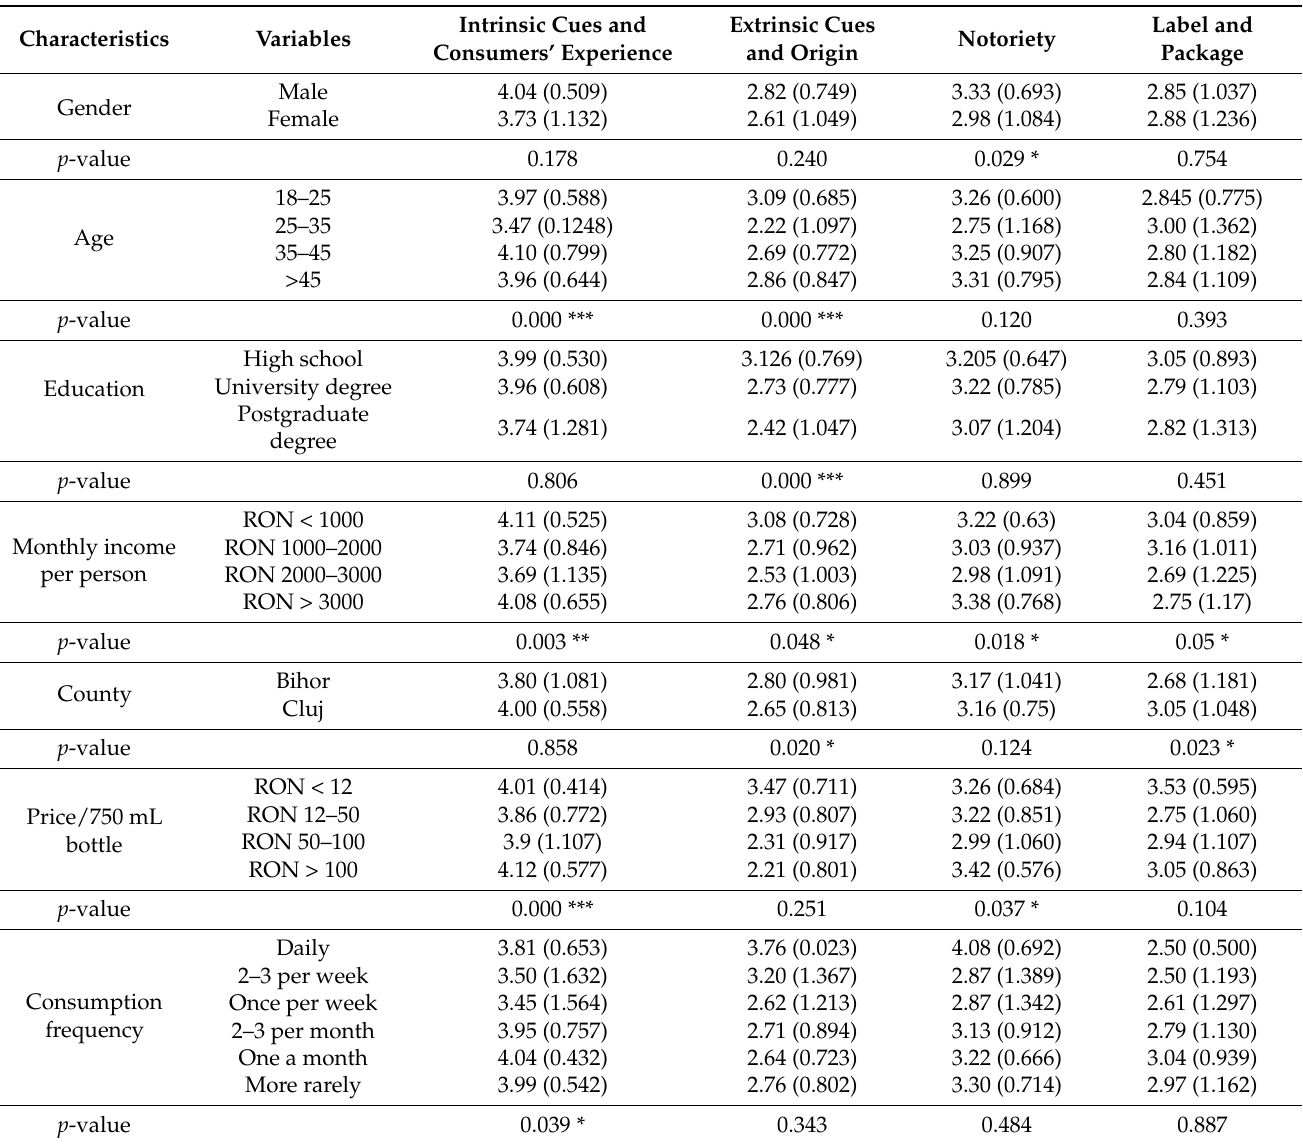
Table 3. Relationship between the socio-demographic characteristics and PCA-resulted